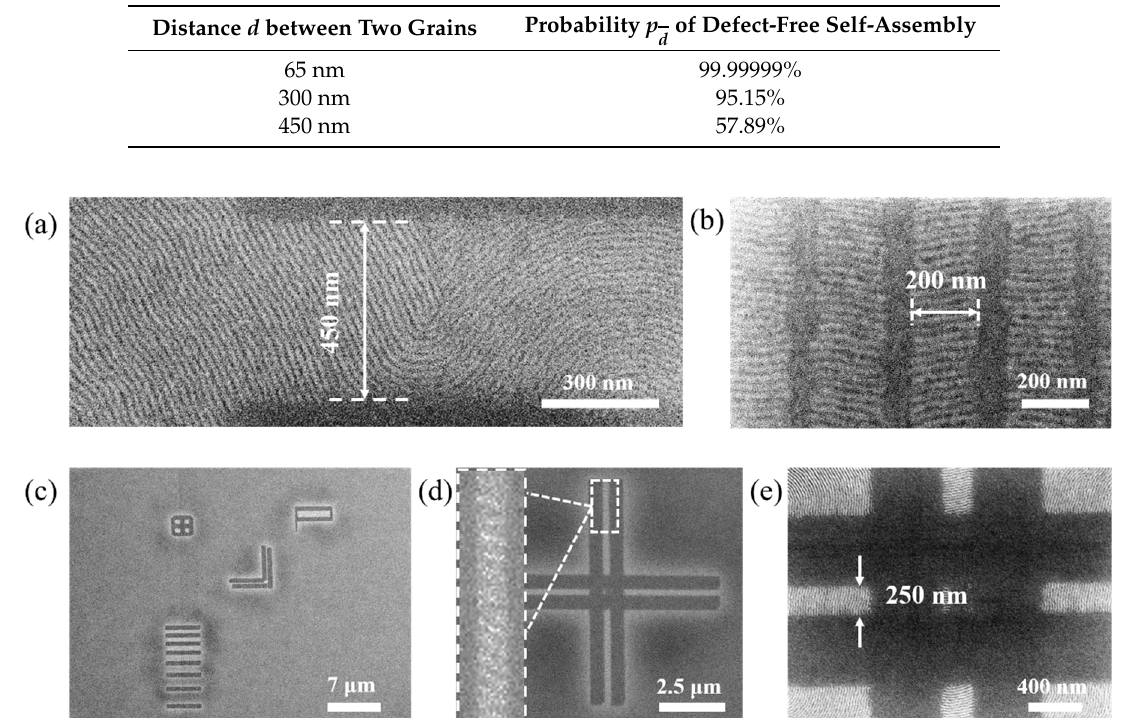
Table 1. Results for the probability of defect free self-assembly between two 5 µ m grain boundaries for three characteristic distances d between the grains. Average correlation length ξ mean is 900 nm.